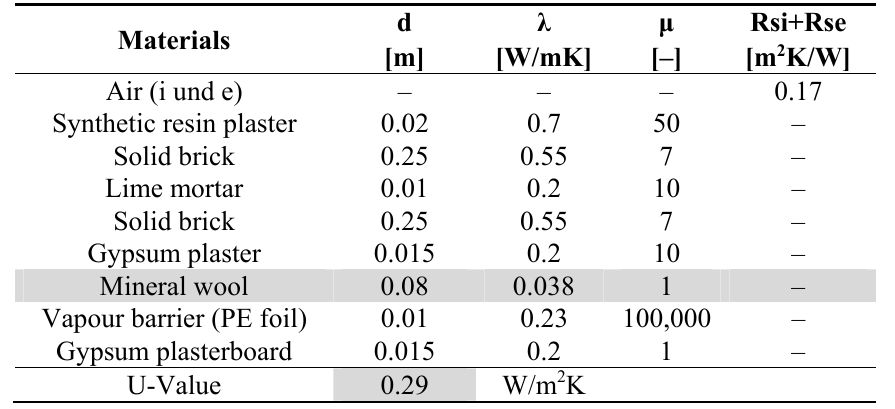
Table 2. Internal insulation with mineral wool. External wall refurbishment with 8 cm of mineral wool, internal insulation.